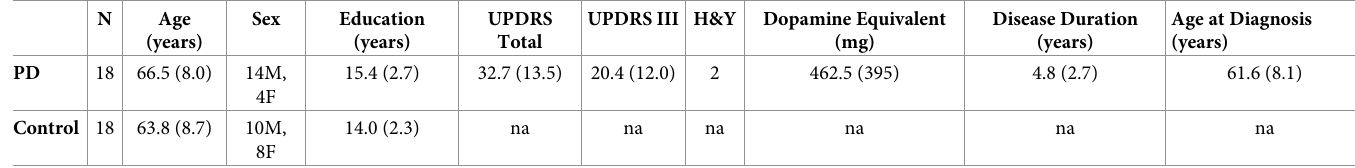
Table 1. Demographic data reported as mean and (SD) except for H&Y, which is the median. M = male, F = female, UPDRS = Unified Parkinson Disease Rating Scale.